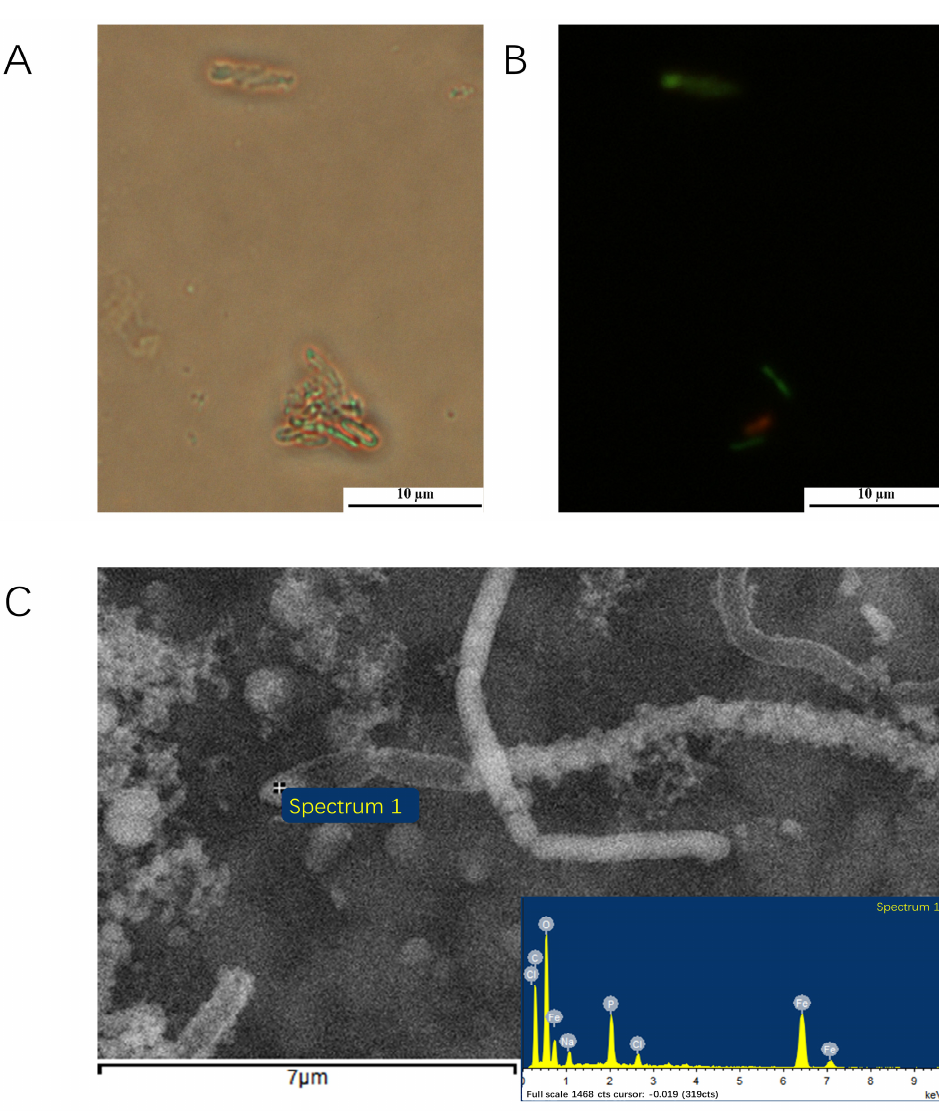
Figure 2. Light ( A ), fluorescence ( B ), and electron ( C ) microscopic images of strain Pseudomonas sp. IOP_13. Cells were grown anaerobically with ferrous chloride (FeCl 2 ) and nitrate (NO 3 −